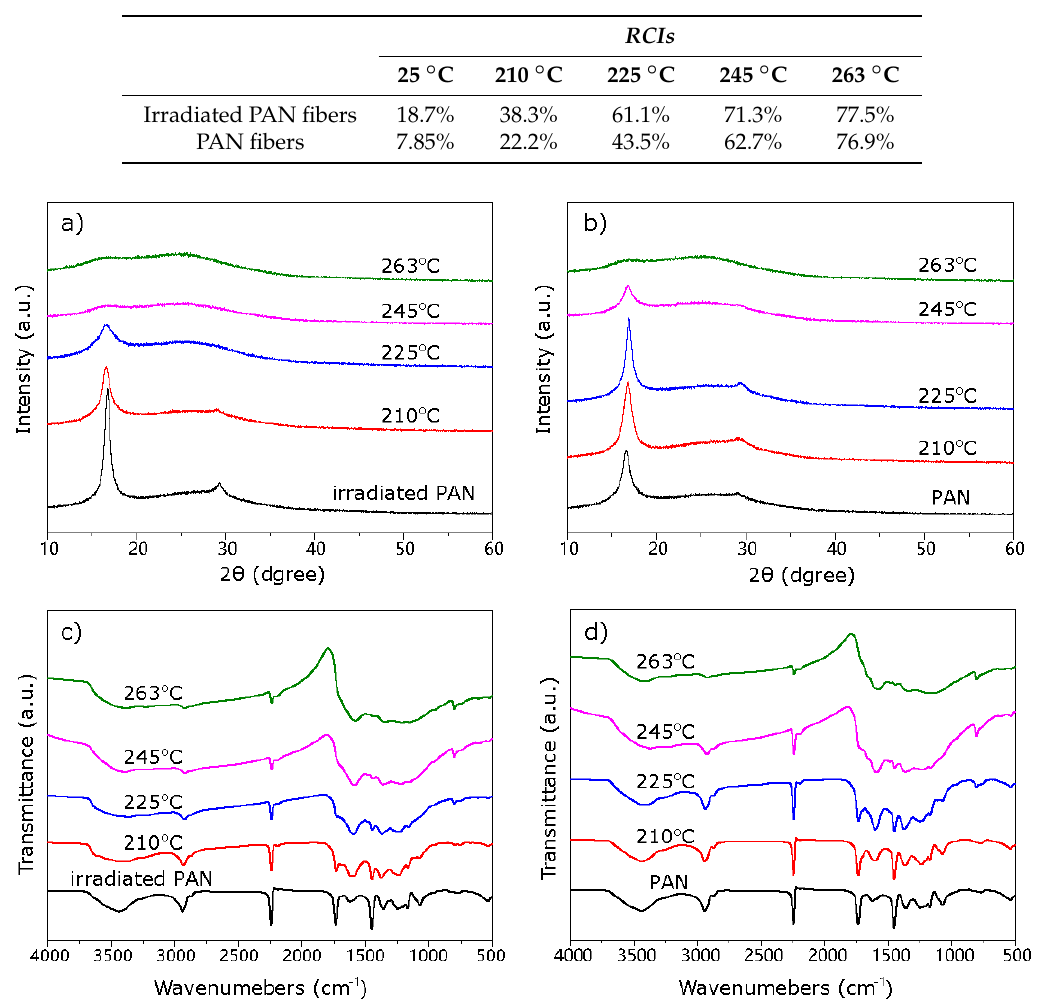
Table 2. The ring closure indexes ( RCIs ) of PAN fibers and irradiated PAN fibers at each stage of thermal stabilization.